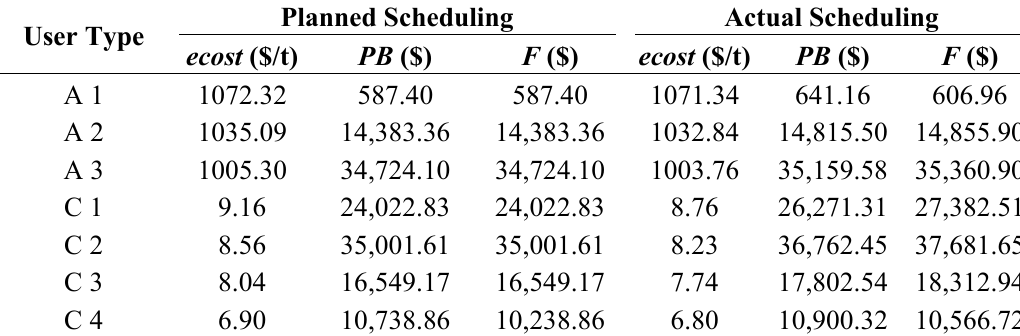
Figure 8. Power deviation from industrial users providing day-ahead AS. Table 9. Revenue comparison between planned and actual AS